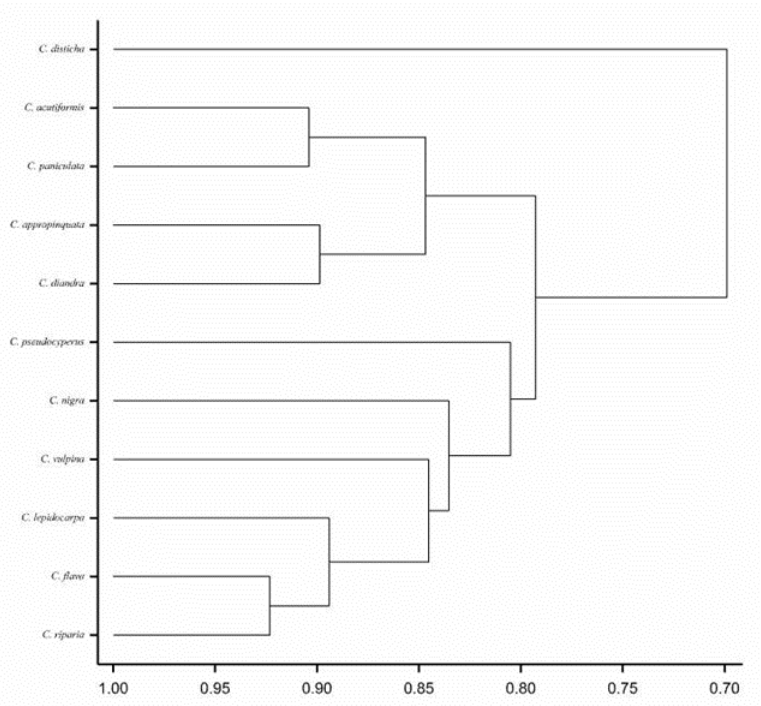
Figure 1. Dendrogram of cluster groupings of Carex taxa based on major and trace element contents in the aboveground biomass.